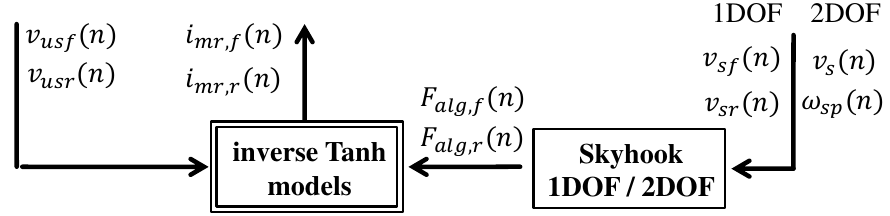
Figure 6. Block diagram of the control algorithm, including inverse Tanh